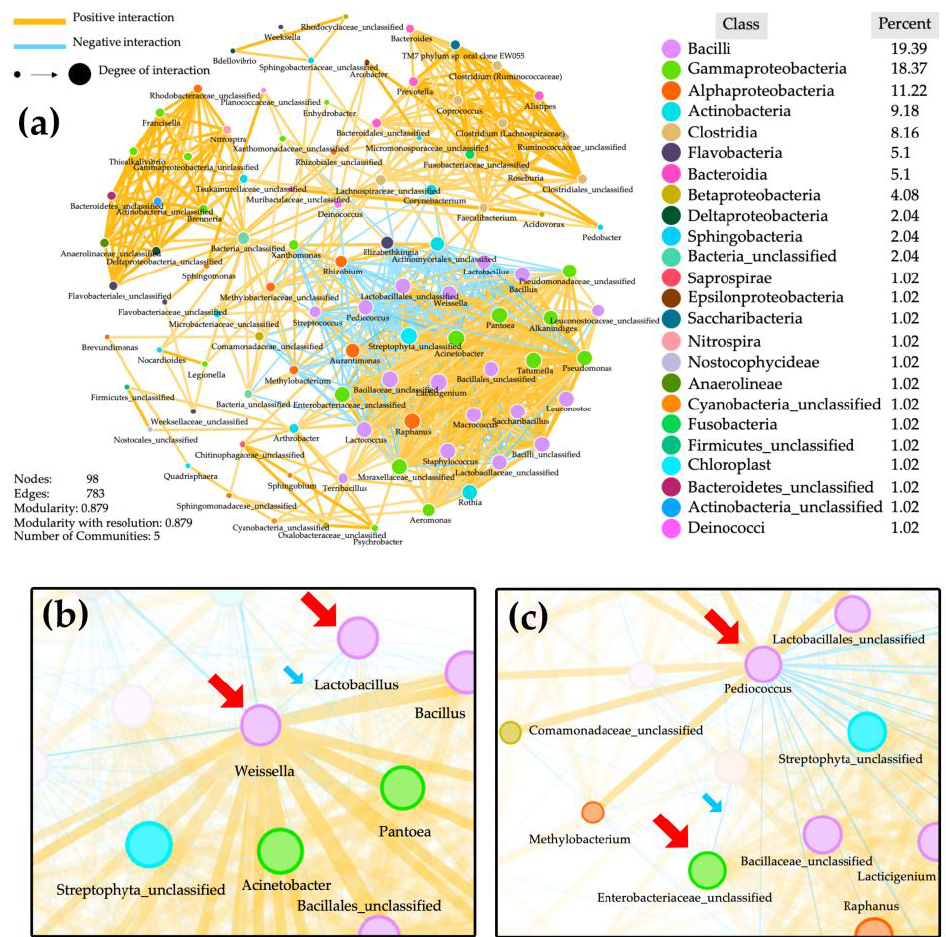
Figure 5. Network analysis of bacterial communities in PGDs, showing 98 nodes of bacterial identities with 783 edges of interactions between the bacterial taxa ( a ), and negative interactions (indicated by blue lines and blue arrows) between Weissella and Lactobacillus ( b ) and between Pediococcus and Enterobacteriaceae ( c ).